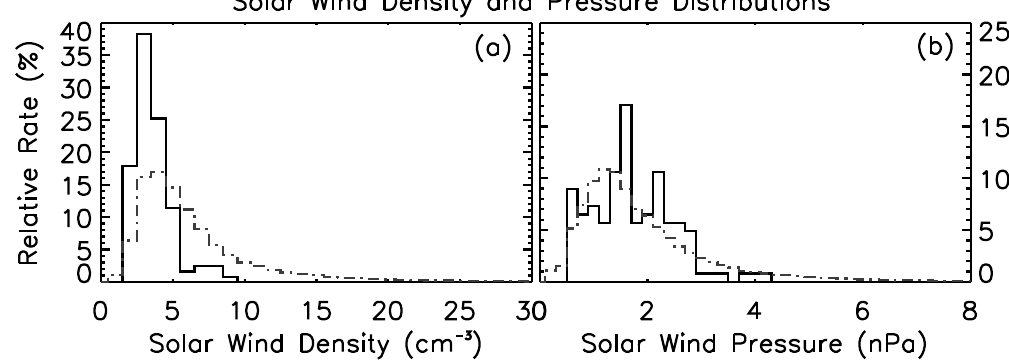
Fig. 11. (a) Solar wind particle density distribution during HFA events (dash-dotted line) using ACE SWEPAM measurements from 1998 to 2008 (solid line). (b) Solar wind pressure in the same time intervals.